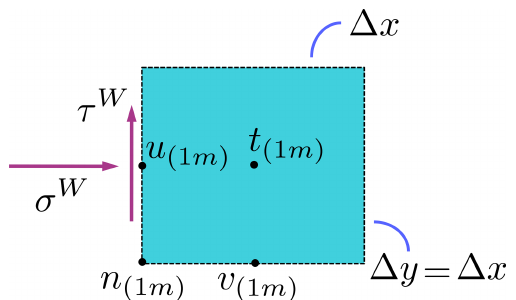
Figure 2. One grid cell on the western boundary of the domain with indices l = 1 and m . This figure shows the location of the velocity components on the C-grid of the McGill model. The variables h and A are positioned at the tracer point t . Some variables (e.g. σ 12 ) are also calculated at the node ( n ) point. The stresses ( σ W and τ W ) applied at the western boundary are shown with purple